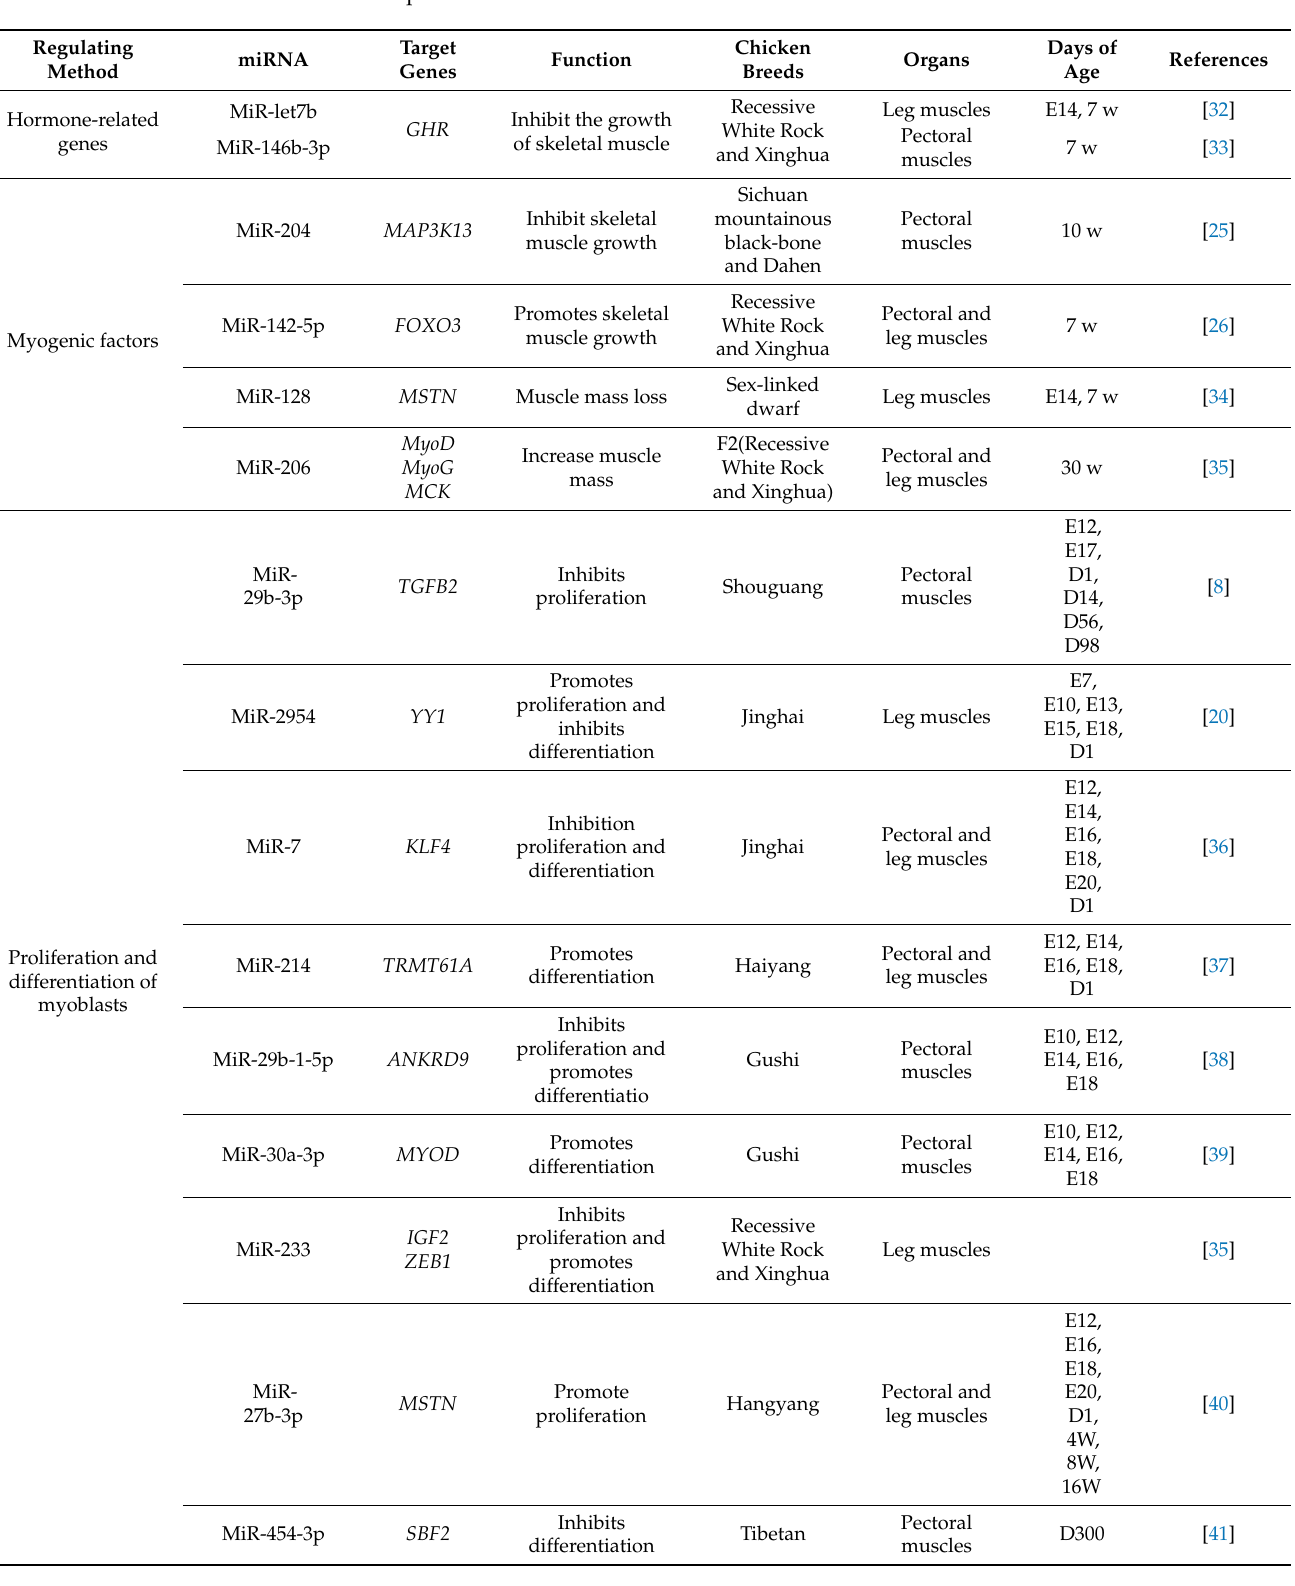
Table 2. Species and functions of miRNAs involved in skeletal muscle of domestic